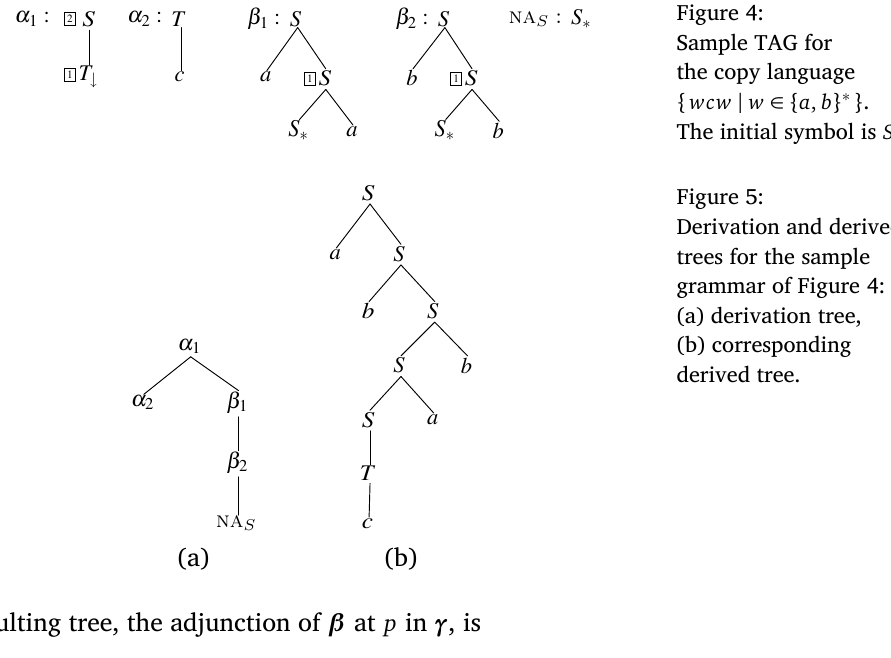
Figure 4: Sample TAG for the copy language f wcw j w 2 f a , b g (cid:3) g . The initial symbol is S # . Figure 5: Derivation and derived trees for the sample grammar of Figure 4: (a) derivation tree, (b) corresponding derived